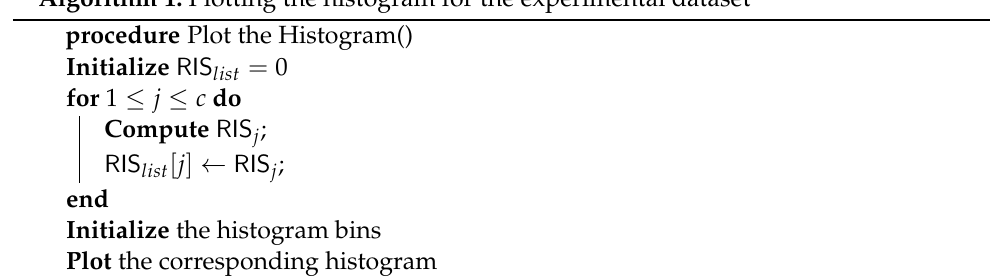
Algorithm 1: Plotting the histogram for the experimental dataset procedure Plot the